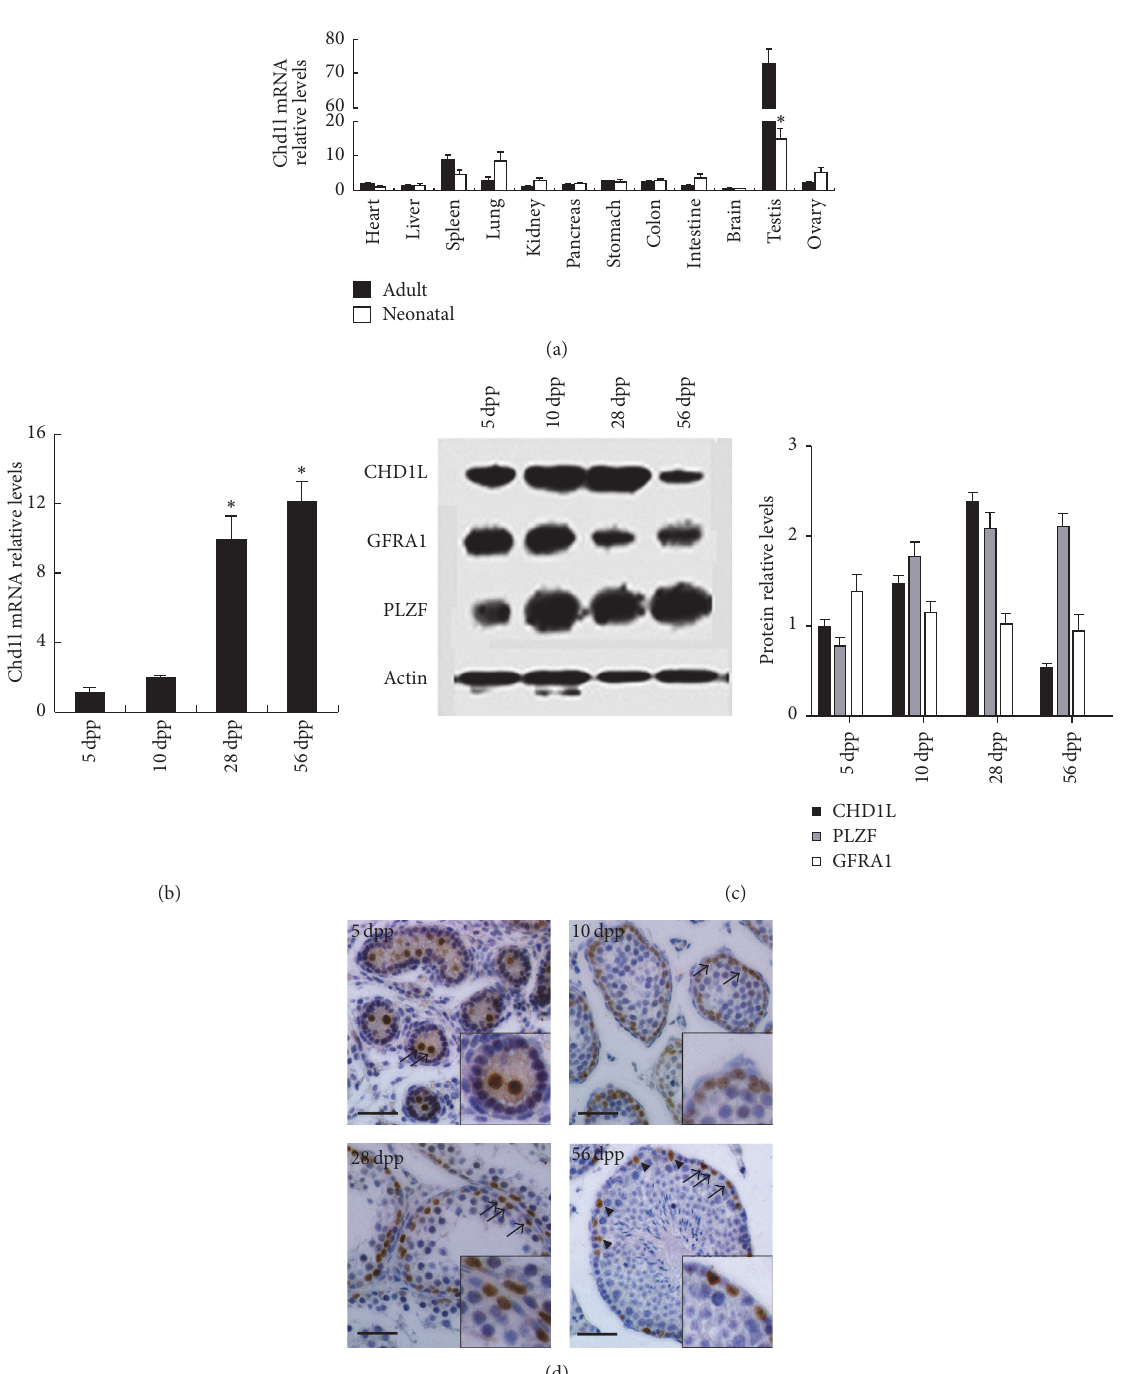
Figure 1: Expression of Chd1l in mouse testes. (a) Chd1l mRNA profiling in developing and adult mouse tissues, as assessed by quantitative RT-PCR analysis. Data presented here are mean ± SD of three animals ( 𝑛 = 3 ). ∗ 𝑃 < 0.05 (versus adult tissues). (b) Expression of Chd1l in developing mouse testis. Data presented here are mean ± SD of three developing mouse testes ( 𝑛 = 3 ). ∗ 𝑃 < 0.05 (versus 5-day testes). (c) Protein expression levels of CHD1L, GFR Α 1, and PLZF in developing mouse testis. Total proteins were harvested and subjected to Western Blot analyses. Representative images (left) and quantitative data (right) from three independent experiments ( 𝑛 = 3 ) were presented here. (d) Immunohistochemistry assays show that CHD1L is mainly expressed in the spermatogonia of the developing mouse testis at 5 dpp, 10 dpp, 28 dpp, and 56dpp. Long arrows indicate the positive (brown) staining in testis sections, and the arrowheads indicate the positive nucleus of Sertoli cells in 56dpp testis sections. Scale bars represent 100 𝜇 m. Insets are magnified views. Representative images from three animals ( 𝑛 = 3 ) were presented here. Quantitative RT-PCR: quantitative reverse transcription-polymerase chain reaction; CHD1L: chromodomain helicase/ATPase DNA binding protein 1-like gene; PLZF: promyelocytic leukemia zinc finger; GFR Α 1: GDNF-family receptor 𝛼 -1; SD: standard deviation; dpp: days